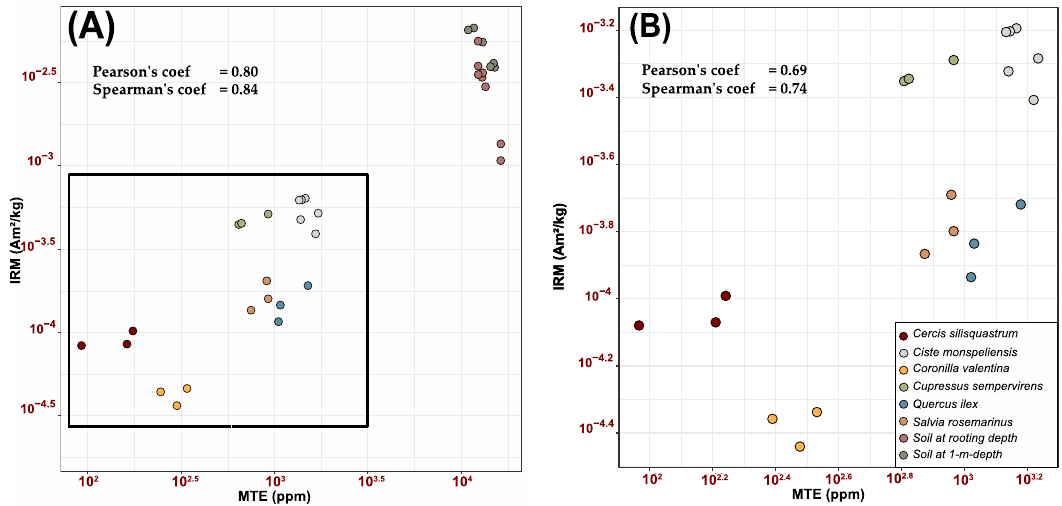
Figure 3. Relationships between Isothermal Remanent Magnetization (IRM 1T ) and concentration in main trace elements (MTE; Mo, Pb, As, Zn, Cu, Ni, Fe, Mn, Cr, V, Sb) for soils and plant leaves ( A ), and only for plant leaves ( B ) harvested on earth-berm.